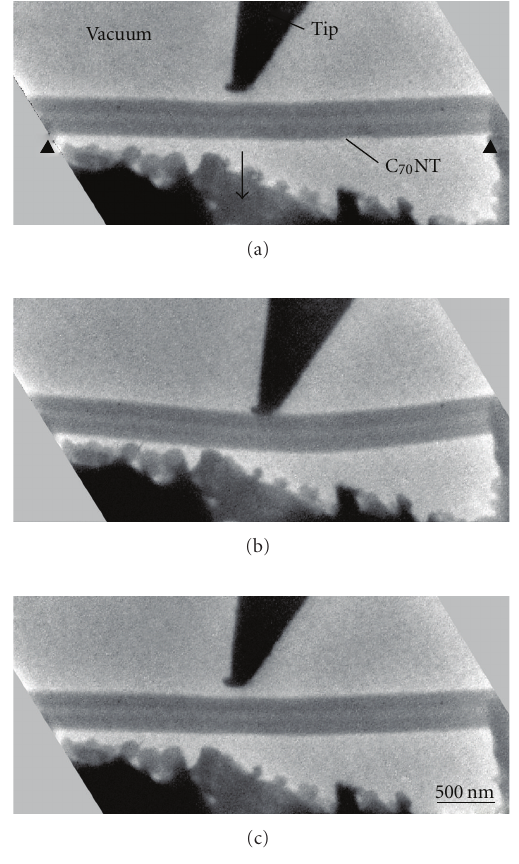
Figure 3: Time-sequence series of bright-field images of loading of simple-beam-type bending of single-crystal C 70 nanotube with outer diameter of 340nm and inner diameter of 80nm. The nano- tube is supported on a gold plate with two fulcra indicated by the triangles. The arrow indicates the loading direction by the tip of the AFM cantilever. This bending test was performed in the vacuum.